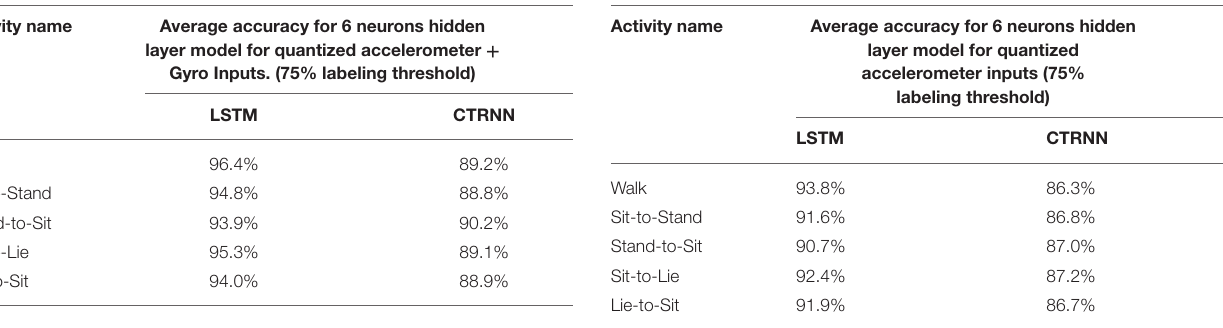
TABLE 2 Baseline performance results for CTRNN and LSTM activity detection models for 5 subjects and 5